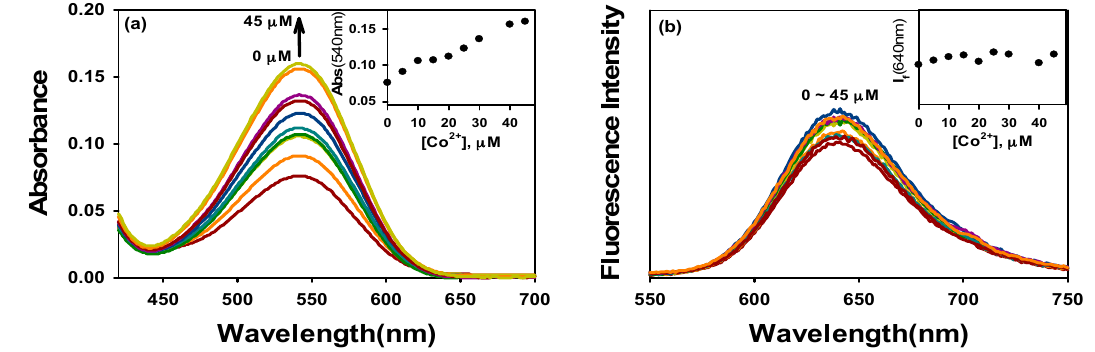
Figure 7. ( a ) Absorption and ( b ) fluorescence spectra of SP-IQ after 350 nm UV irradiation for 7 min with the various concentration of Co 2+ (0~45 µ M, Different color lines represent different Co 2+ concentrations.). Inset: Plots of ( a ) absorbance at 540 nm and ( b ) fluorescence intensity at 640 nm vs . [Co 2+ ].